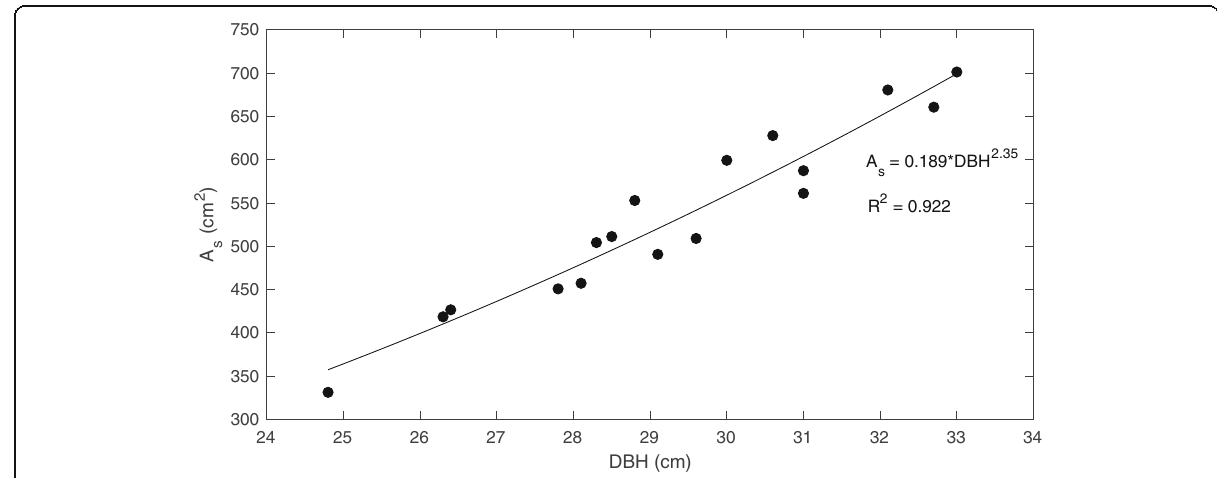
Fig. 2 A species-specific allometric equation relating sapwood area ( A s ) to tree diameter measured at breast or 1.3 m height